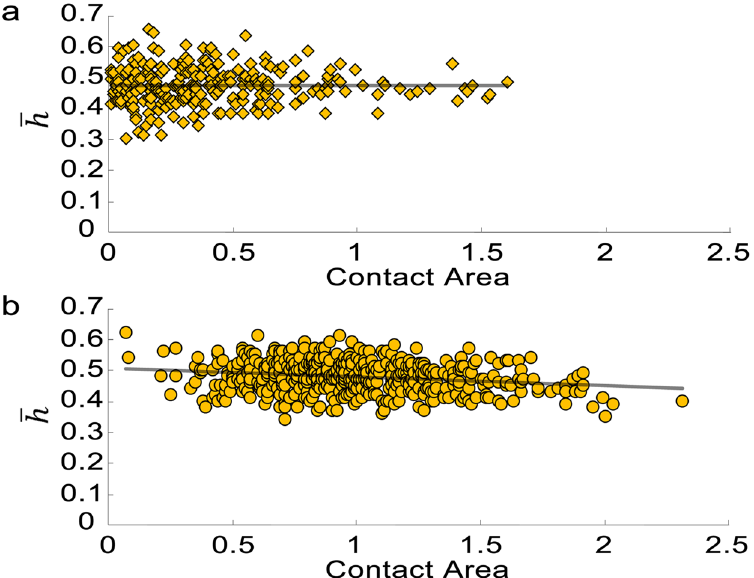
Figure 5. Scatter plot of the average height of the AZM connection sites ( h ) as a function of the contact area of the vesicle with the PM. ( a ) When the AZM connection sites are randomly distributed on the hemispherical surface of a vesicle facing the PM, the contact area of the vesicle has no significant correlation with the average AZM connection sites based on the results of the 500 simulated SVs (r = 0.0019, p = 0.98). It should be noted that only 266 SVs out of 500 simulated SVs are docked with the PM. ( b ) However, when the AZM connection sites are randomly distributed on the upper half of the hemisphere of an SV, the contact area is correlated with the average AZM connection sites based on the results of the 500 simulated SVs (r = − 0.21, p = 3.4 × 10 − 6 ). Conversely, when the AZM connection sites are randomly distributed on the lower half hemisphere of an SV, based on the results of the 500 simulated SVs there are almost no docked SVs ( < 0.03%) indicating that the positions of the AZM connection sites on the vesicle surface influence on the portion of the docked SVs (see Fig.